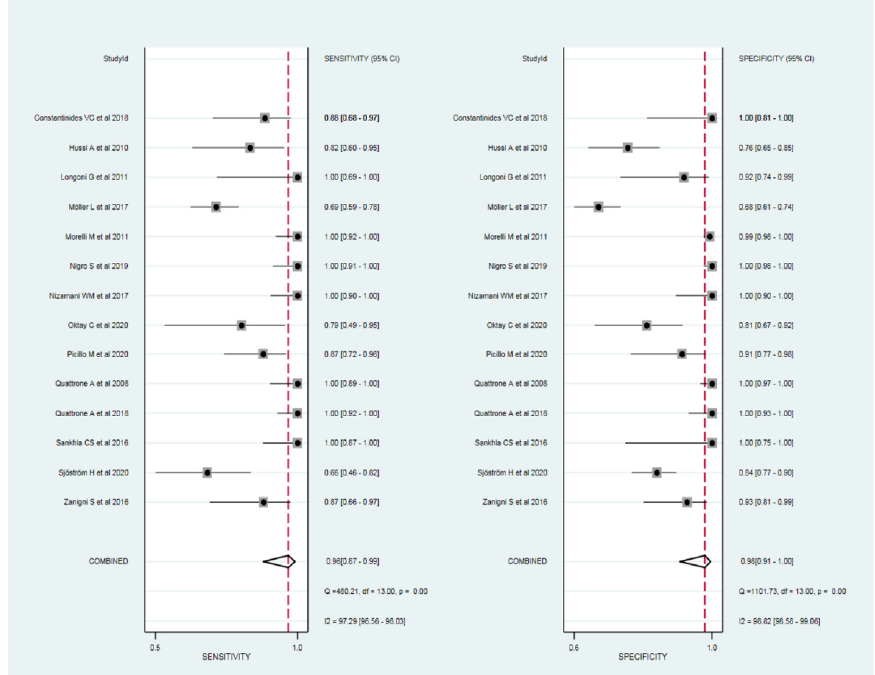
Figure 3. Coupled forest plots of the pooled sensitivity and specificity for the diagnostic performance of the MRPI for the differentiation of progressive supranuclear palsy from Parkinson’s disease. Numbers are pooled estimates with 95% CIs. Horizontal lines represent 95% CIs. Red dotted lines represent pooled sensitivity and specificity, respectively. COMBINED column represent 95% CIs of the pooled sensitivity and specificity. MRPI, magnetic resonance parkinsonism index; CI, confidence interval. Diagnostics 2022 , 12 , x FOR PEER REVIEW